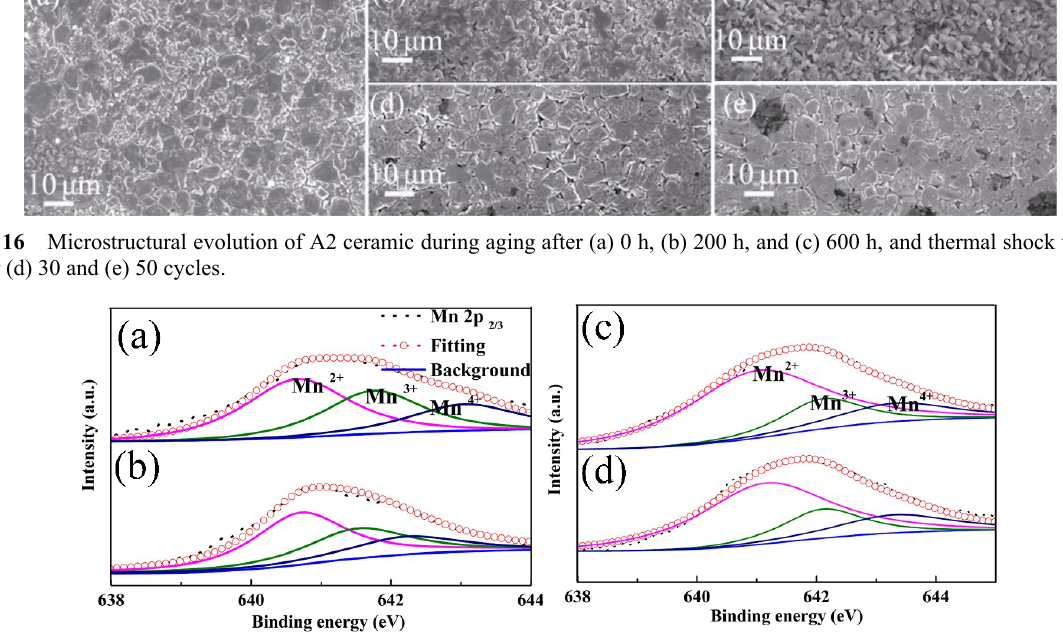
Fig. 17 High-resolution Mn 2p 3/2 XPS spectra from A2 ceramic during aging after (a) 200 and (b) 600 h, and thermal shock testing after (c) 30 and (d) 50